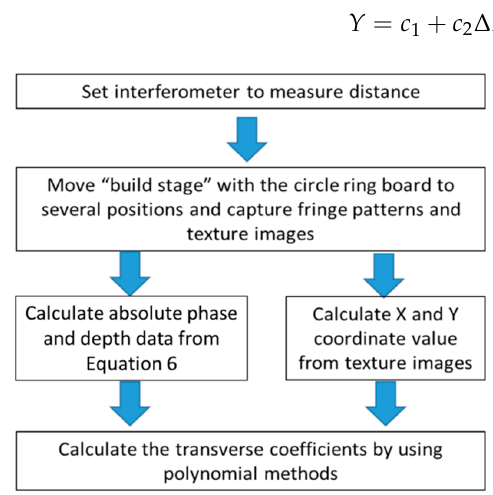
Figure 7. The procedure of transverse calibration.